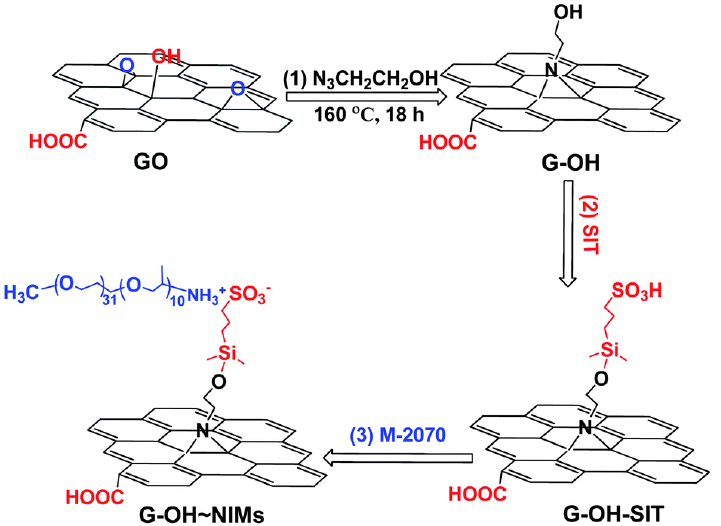
Figure 8. Schematic of the G-OH nanoscale ionic materials: (1) graphene oxide is surface- functionalized with 2-azidoethanol to obtain hydroxyl-rich graphene (G-OH); (2) G-OH is modified by condensation with a sulfonate organosilane (SIT) to prepare the acidic graphene (G-OH-SIT); and (3) G-OH-SIT is neutralized with the basic amino-terminal block copolymer M-2070 via acid–base reactions. Reprinted with permission from Wu et al. [104].